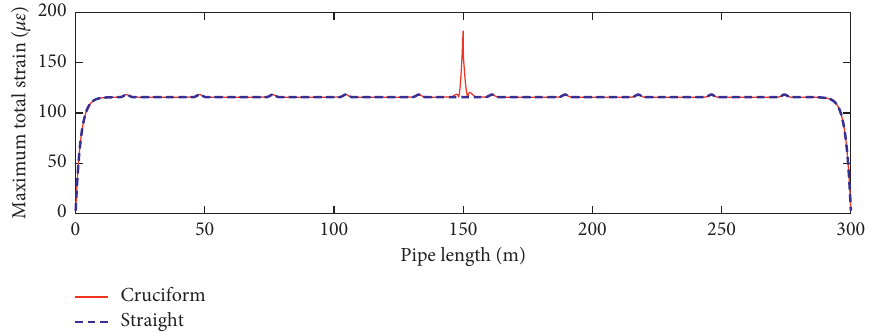
Figure 14: Maximum total strain of straight pipe and cruciform